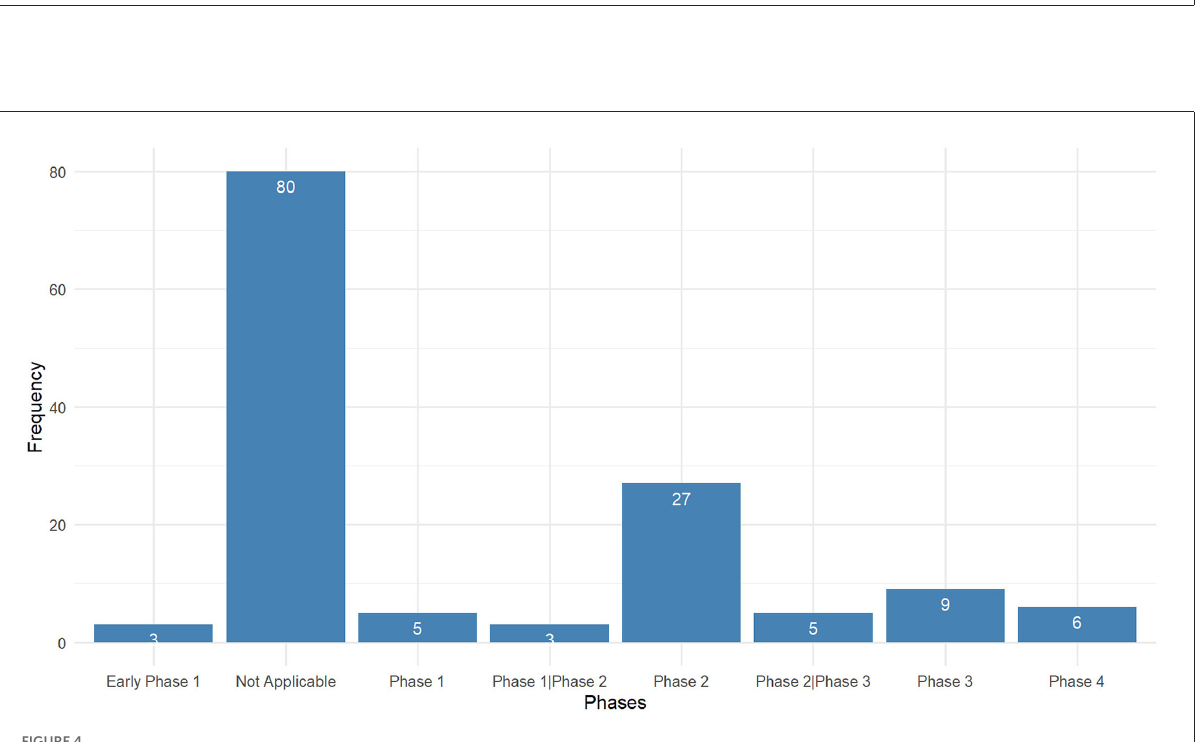
FIGURE4 Study type of interventional clinical trails for